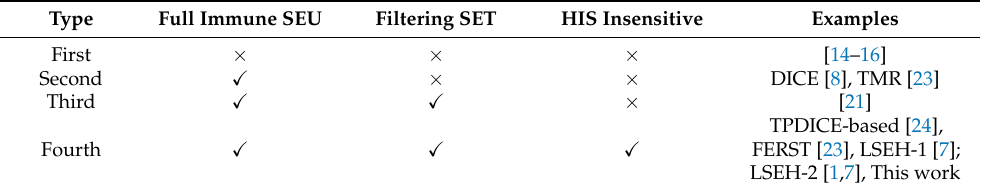
Table 1. Classification of different type of D-latch in regard to their soft-error